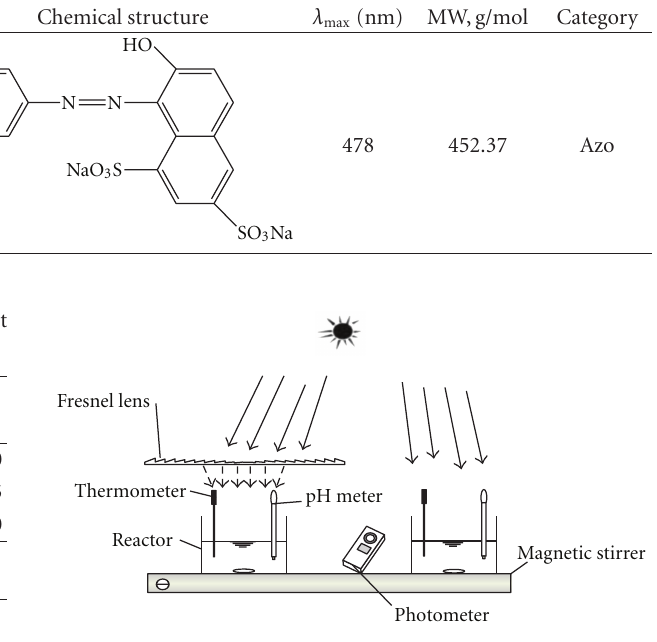
Figure 1: Schematic diagram of the solar photocatalytic reactor with and without Fresnel